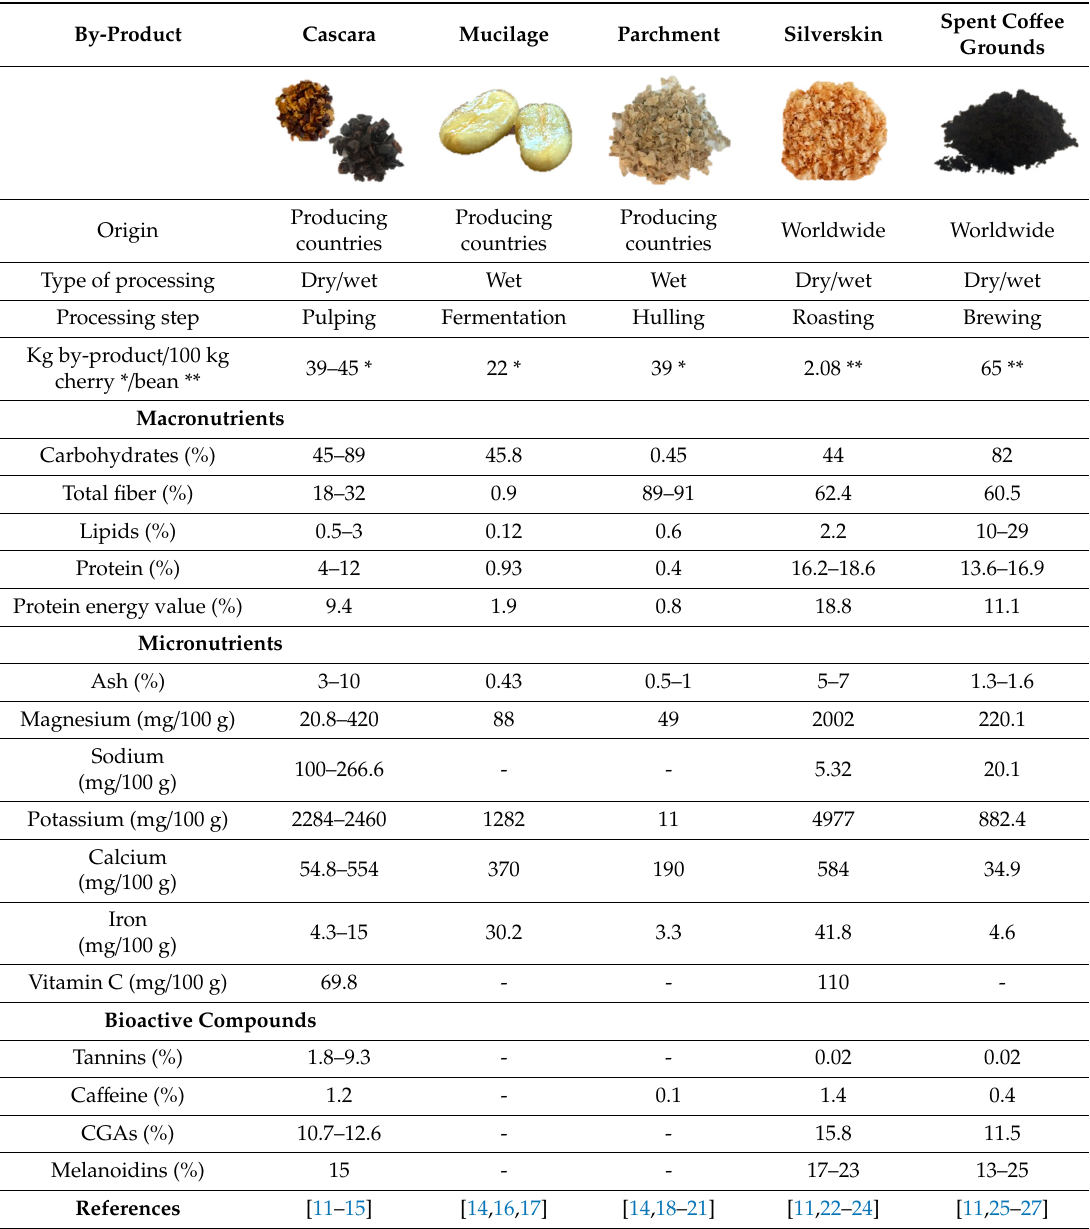
Table 1. Origin, type of processing, processing step and the nutritional and bioactive compound composition of coffee by-products. Data are expressed in% of dry matter.